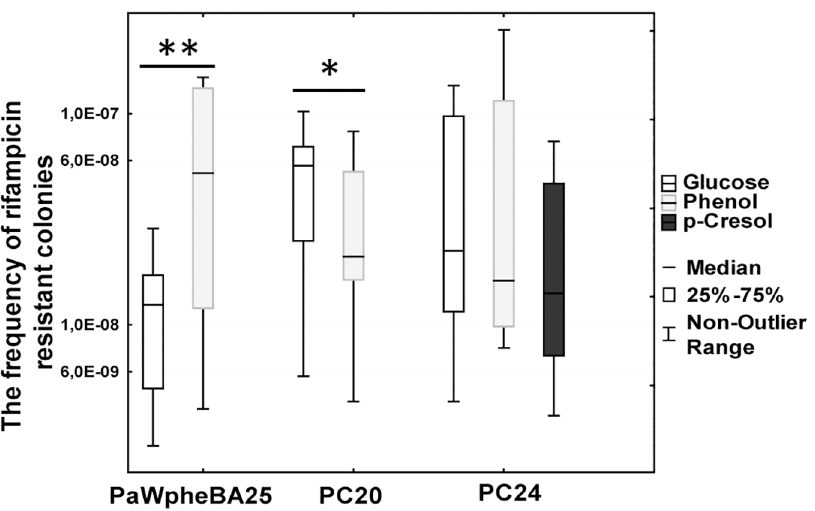
Fig 8. The frequency of rifampicin resistant colonies in M9 minimal medium which contained either glucose, phenol (2.5 mM) or p -cresol (1.25 mM) as the only carbon source. Data were analysedusing the Kruskal-Wallis test (S11 Table). * designates P < 0.025and ** designates P <